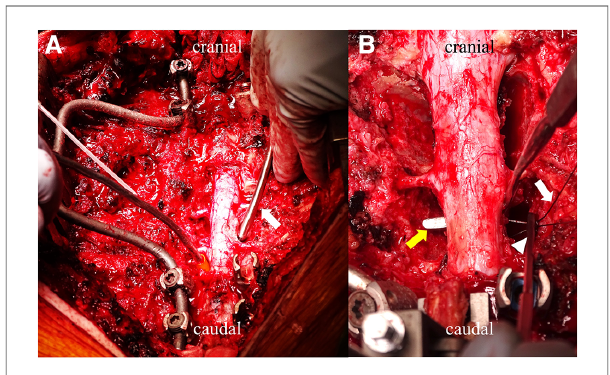
FIGURE 1 Intraoperative photographs of our modi fi ed ohtsuka procedure. ( A ) Using a curved air drill (white arrow), partial osteotomy of the vertebral bodies adjacent to the targeted ossi fi cation of the posterior longitudinal ligament (OPLL) is performed to make a “ bone tunnel ” at the posterior part of the vertebral bodies. ( B ) The posterior longitudinal ligament is cut at the cranial side of the OPLL by a threadedwire saw (white arrow) with a knot pusher (arrowhead) used under an angled spatula (yellow